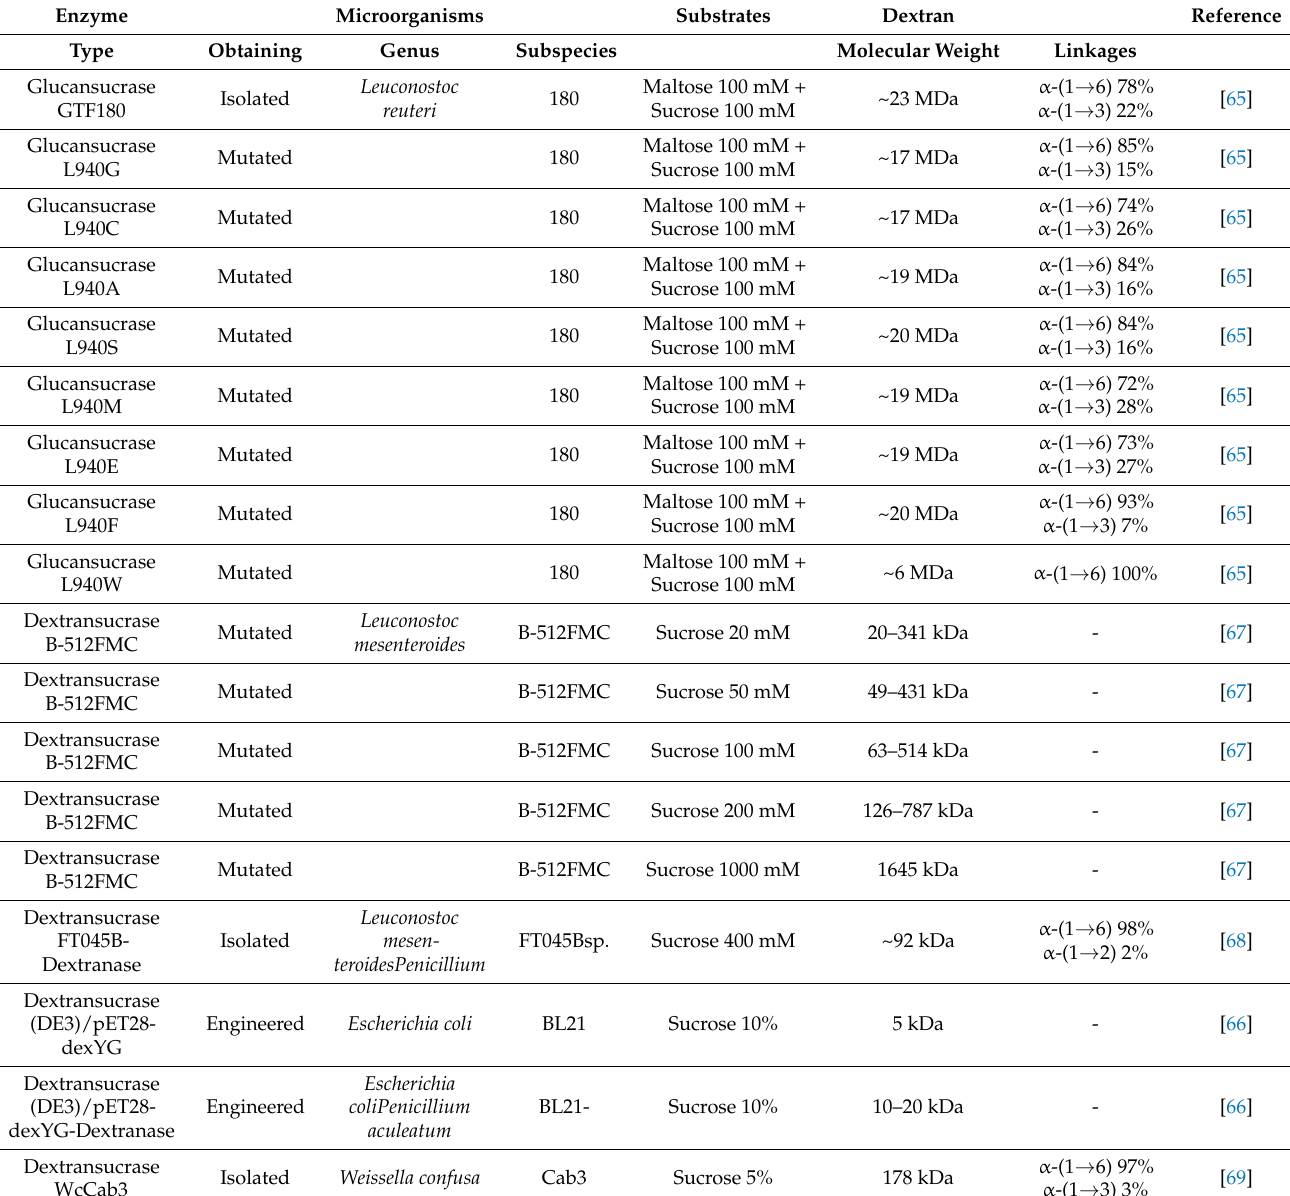
Table 2. Dextrans synthesized by enzymes isolated from different